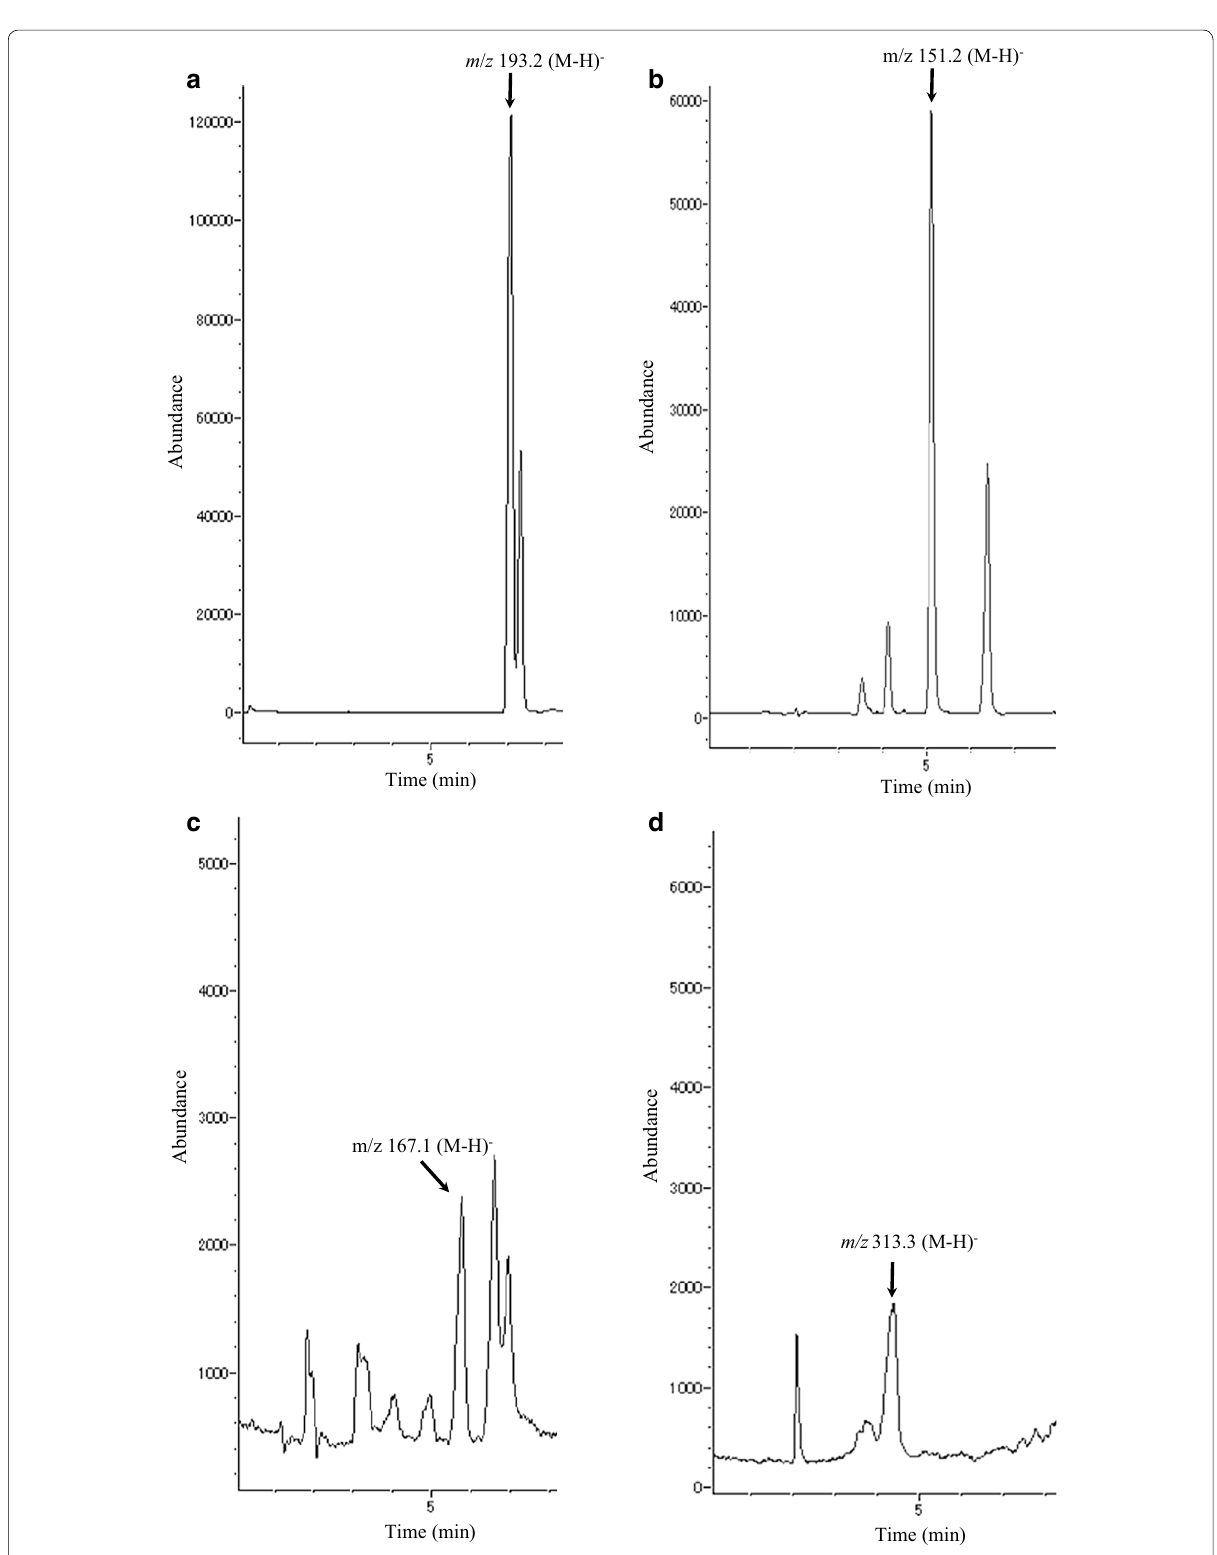
Fig. 2 Total ion chromatogram obtained from the biotransformation of phenolic compounds in Aspergillus luchuensis . The total ion chromatogram (TIC) was measured by LC/MS. Each TIC mass spectrum for a ferulic acid ((M-H) − , 193.2), b vanillin ((M-H) − , 151.2), c vanillic acid ((M-H) − , 167.1), d vanillin glucoside ((M-H) − , 313.3) and individual retention times were identical to those of the authentic